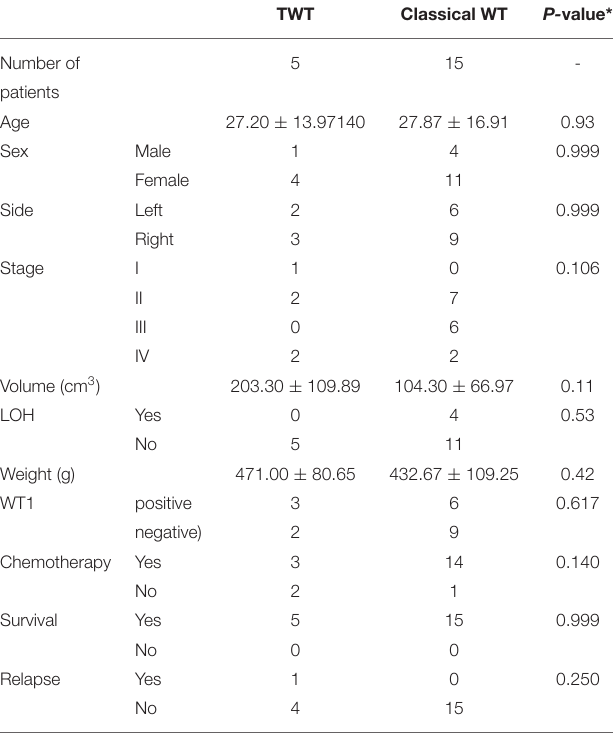
TABLE 2 | Patient demographics, clinical characteristics, and prognostic outcomes in individual groups.